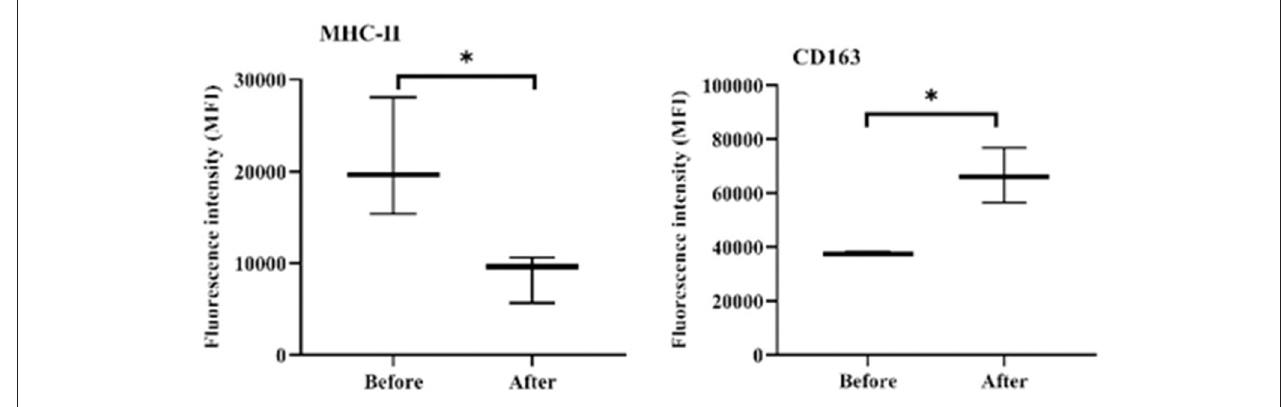
FIGURE 8 | Expression densities of the cell surface molecules MHC-II and CD163 on camel monocytes. Monoclonal antibodies to CD14, MHC-II, and CD163 were used to mark separated camel leukocytes, and the labeled cells were examined by flow cytometry. The expression levels of MHC-II and CD163 were evaluated as MFIs of the investigated markers after gating on camel monocytes (based on their positive staining with CD14). *indicates a significant difference ( p -value < 0.05) between groups as analyzed by the Mann–Whitney